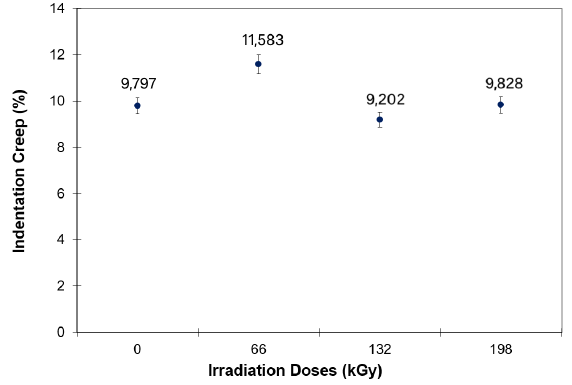
Figure 3. Indentation hardness of tested PBT 35%GF.